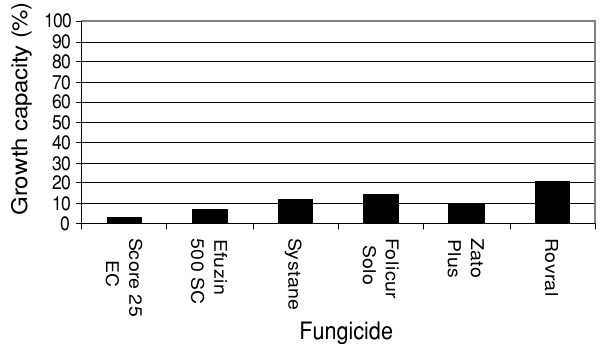
Figure 4. Percent growth capacity of Spilocaea pomi for 6 fungicides (approved in integrated production) admended on PDA plates at 0.5 × dosage recommended by the manufacturer (LSD